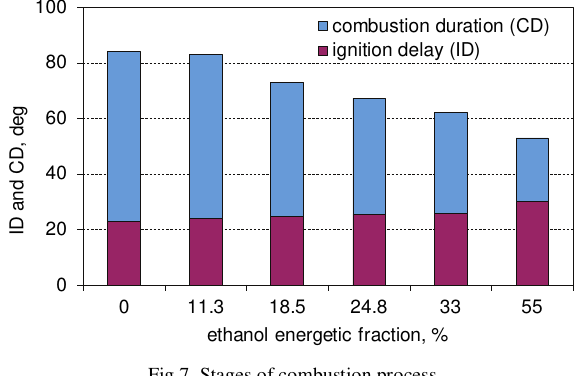
Fig 7. Stages of combustion process